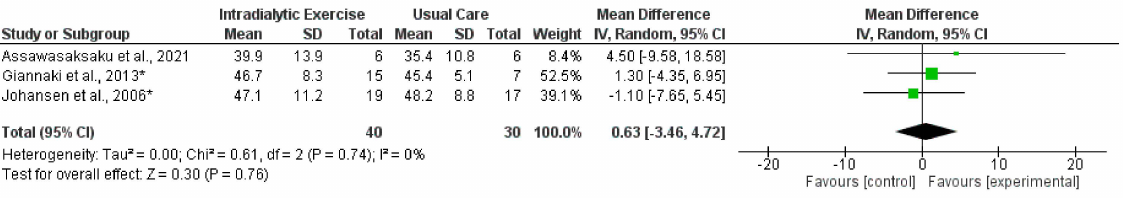
Figure 6. Effect of intradialytic exercise on lean whole body mass (kg) measured by DEXA in individuals receiving haemodialysis. Data are expressed as mean difference and 95% CI. * Data for exercise and control groups only